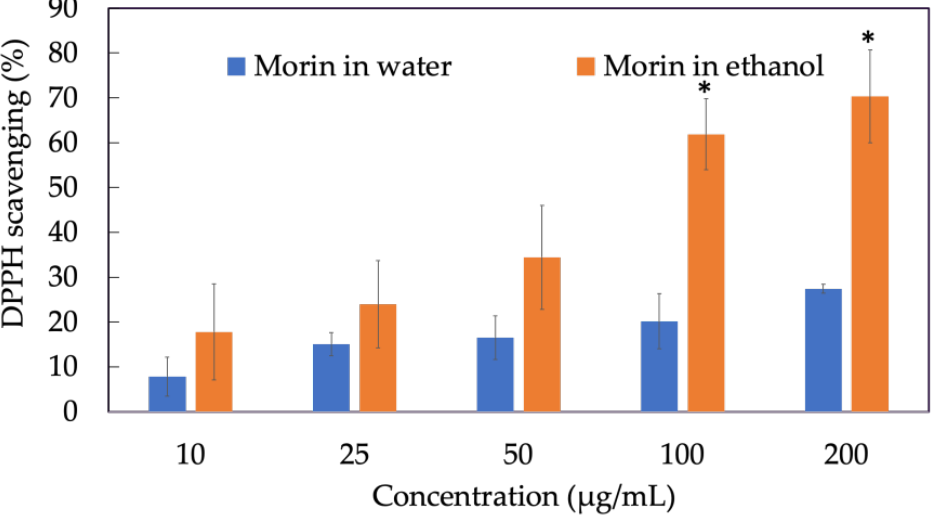
Figure 1. DPPH • radical scavenging activity of morin in water and in ethanol. Data were from triplicate experiments and presented as mean ± SD. * indicates a statistically significant difference between morin in water and morin in ethanol, p < 0.05.